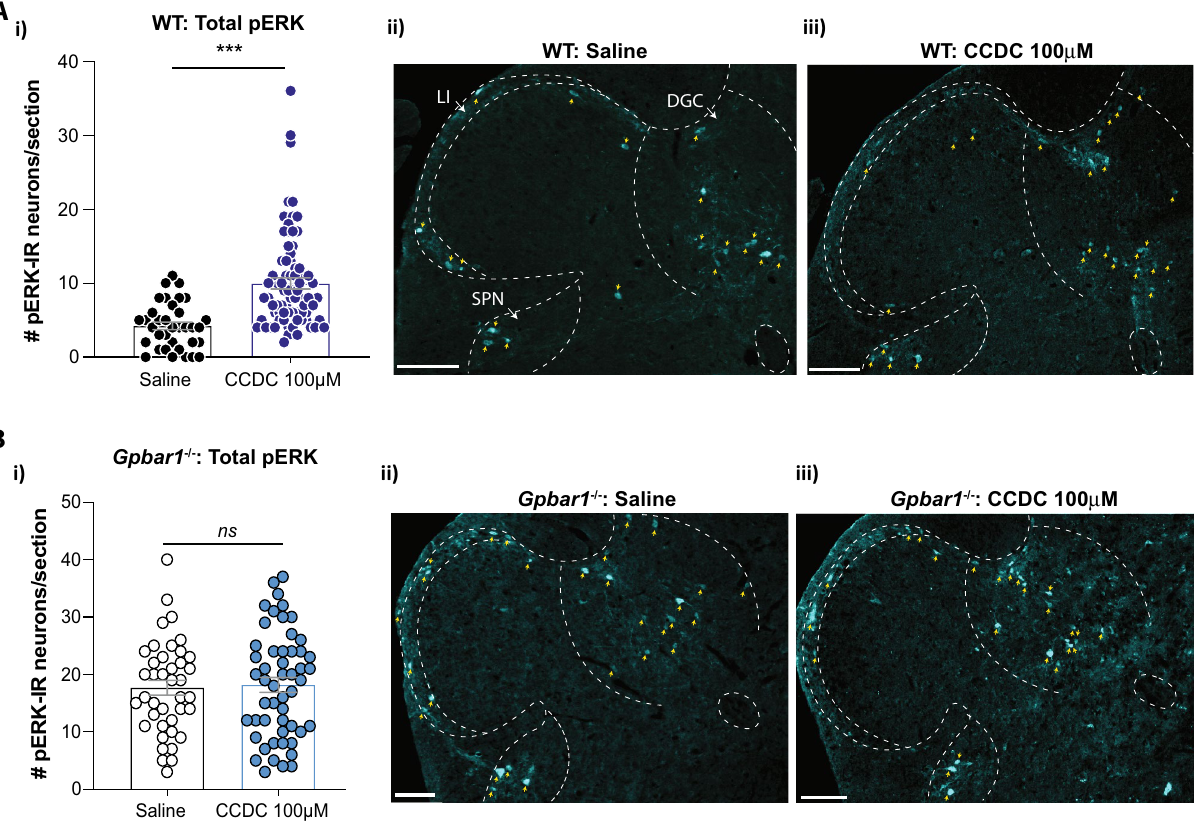
Figure 4. Intravesical bladder CCDC administration increases spinal dorsal horn pERK immunoreactivity in response to bladder distension. ( A ) ( i ) In vivo bladder distensions in wildtype mice following intravesical saline (control) or CCDC (100 µM) administration. Group data showing the number of pERK-immunoreactive (pERK-IR) dorsal horn neurons in 10 µm sections of the lumbosacral spinal cord. Compared to saline (N = 4), the number of pERK-IR neurons in the LS dorsal horn per section was significantly greater in response to bladder distension following intravesical administration of CCDC (N = 6; *** P < 0.001). ( ii–iii ) Images are representative dorsal horn sections from the S1 region from ( ii ) saline-treated and ( iii ) CCDC-treated wildtype mice, with dashed lines to delineate the superficial dorsal horn (SDH) and dorsal grey commissure (DGC), and yellow arrows pointing to pERK-IR neurons. ( B ) ( i ) In Gpbar1 −/− mice there was no difference observed in the number of pERK-IR neurons in the LS dorsal horn per section following bladder distension following intravesical administration of either saline (N = 3) or CCDC (N = 4; ns, P > 0.05). Images are representative dorsal horn sections from the S1 regions from ( ii ) saline-treated and ( iii ) CCDC-treated Gpbar1 −/− mice, with dashed lines to delineate the superficial dorsal horn (SDH) and dorsal grey commissure (DGC), and yellow arrows pointing to pERK-IR neurons. Data are represented as mean ± SEM, with each dot representing the total number of pERK-IR neurons within a single dorsal horn quadrant from one section. P values were determined by Mann–Whitney non-parametric test ( Ai , Bi ). Scale bar 100 μm throughout. CC central canal, SPN sacral parasympathetic nucleus, LSN lateral spinal